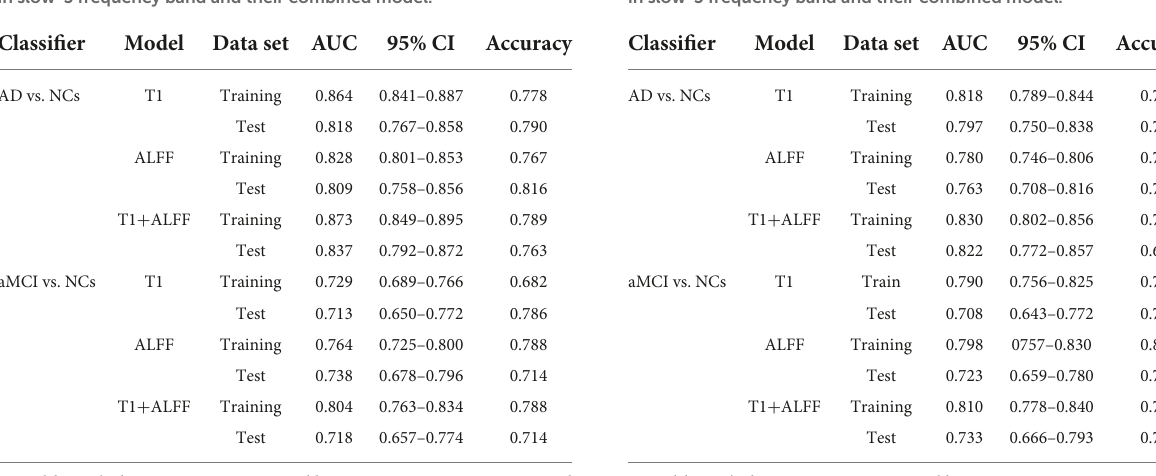
( z = 1.763, P = 0.078) than the right hippocampal structural model (AUC = 0.790).